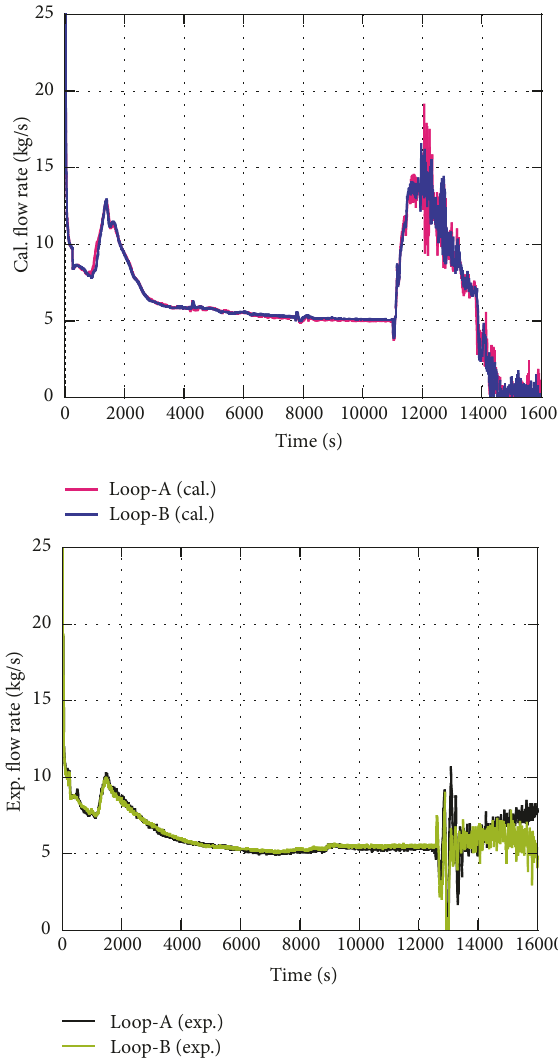
Figure 29: TR-LF-16test and RELAP5 results for primary mass flow rate in each